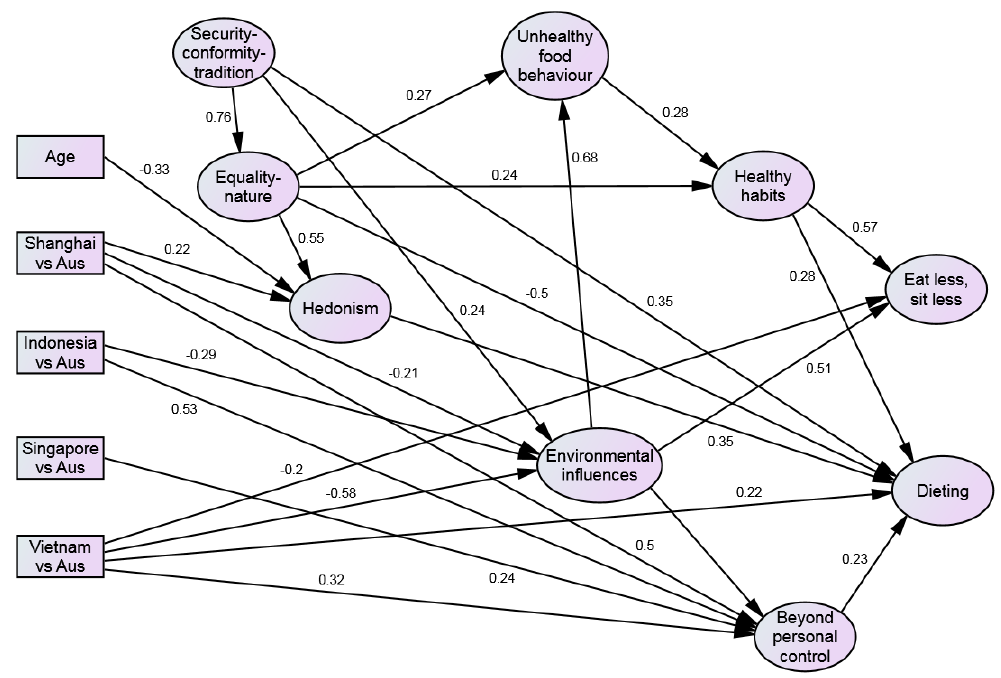
Figure 2. Structural equation model with the standardised pathway coefficients greater than 0.20 being displayed. Note: only regression weights >0.20 are shown here.